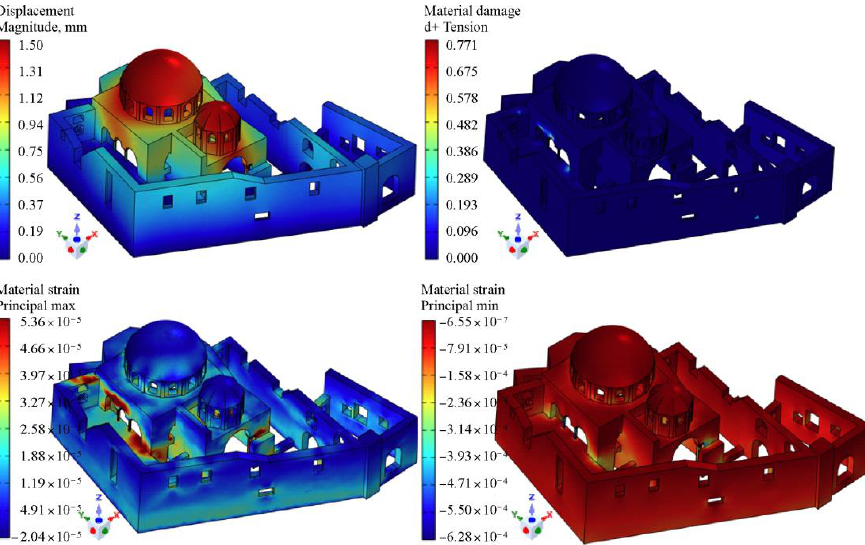
Figure 15. Displacements, material damages and max/min principal strains under vertical